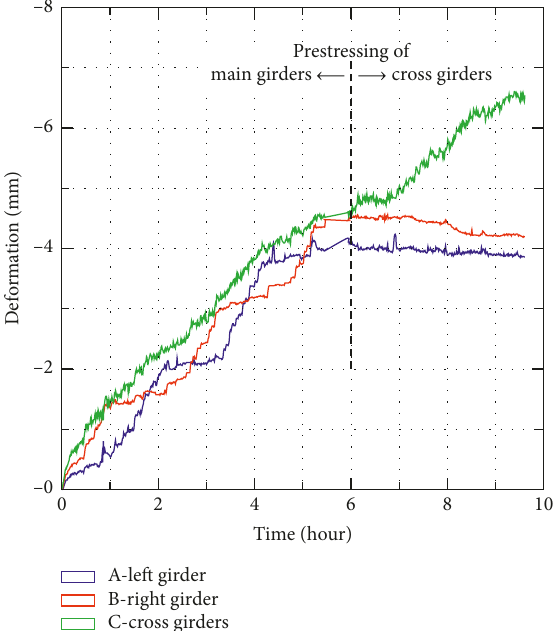
Figure 19: Measured deflections of the main girders and the cross girders during prestressing of the structure [21]. The graph shows the deformation effect of post-tensioning and documents an ef- fective transfer of prestressing forces into the